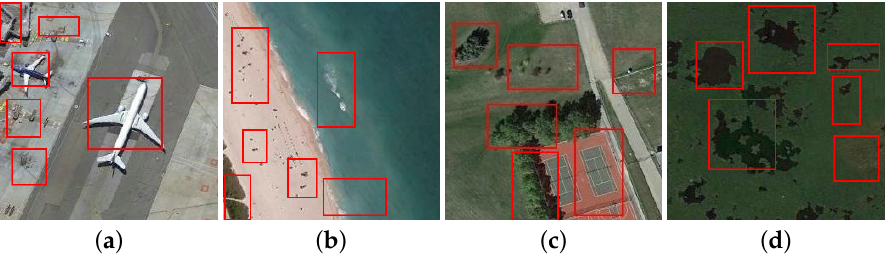
Figure 12. Some visual examples that show the discriminative regions obtained by ADRL-Net. ( a ) Airport; ( b ) Beach; ( c ) Tennis court; ( d ) Wetland.